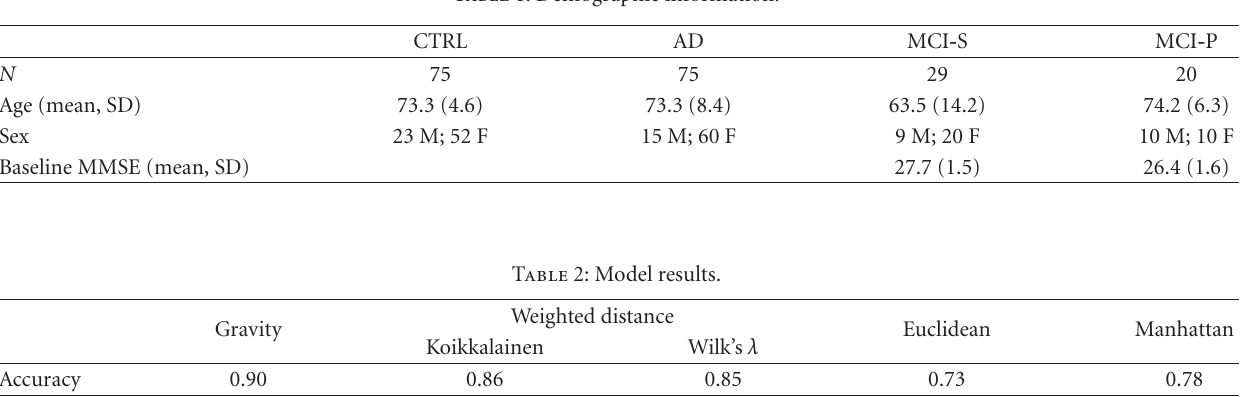
Table 1: Demographic information.